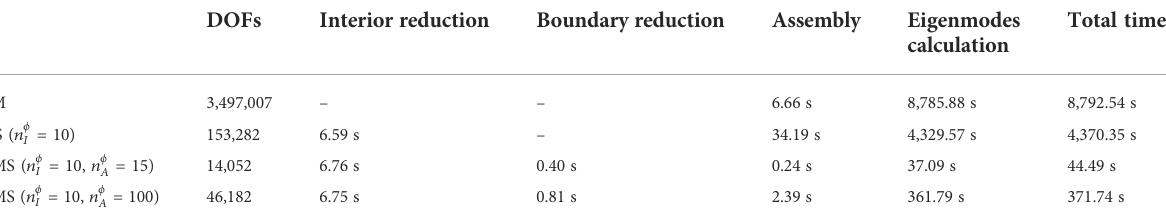
TABLE 2 Overviewof 15 × 15 UC fi nite LRM plate FOM, BMS and GBMS based model sizes and computational times required for the model reduction, assembly and eigenmodes